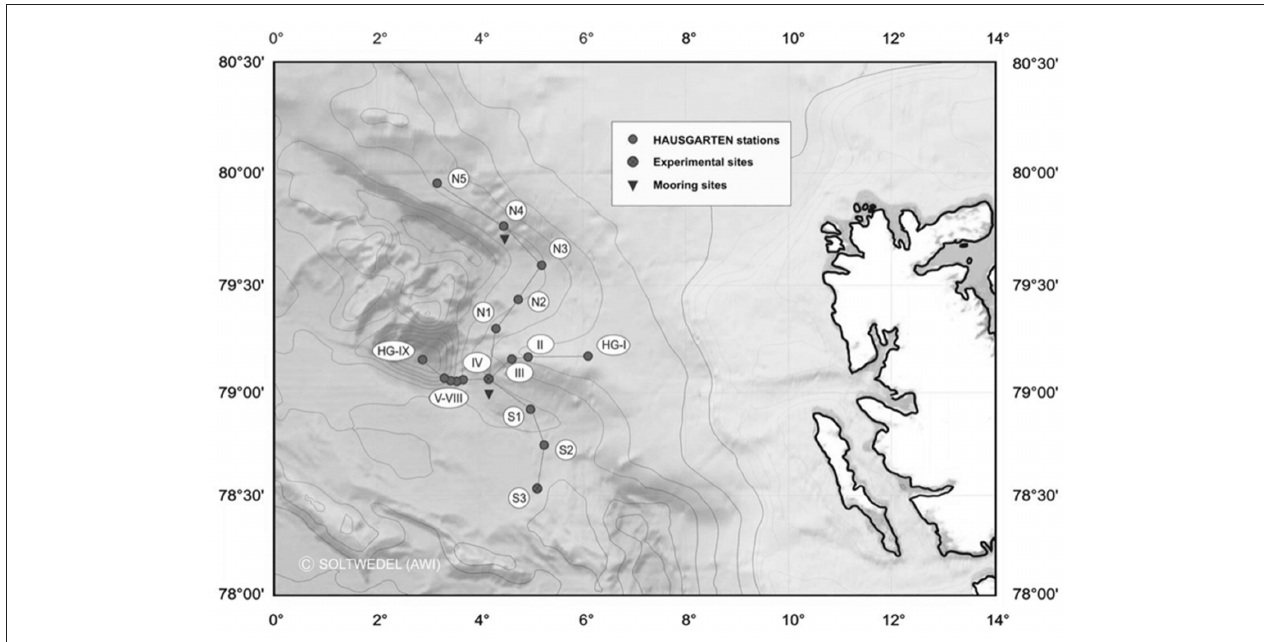
FIGURE 1 | Map of the “Hausgarten” of the Alfred Wegener Institute for Polar and Marine Research in the Eastern Fram Strait. Black dots in the map mark the location of the stations. The central station (HG4) of the “LTER (Long-Term Ecological Research) observatory HAUSGARTEN” is labeled in the map as “IV” (copyright Soltwedel,